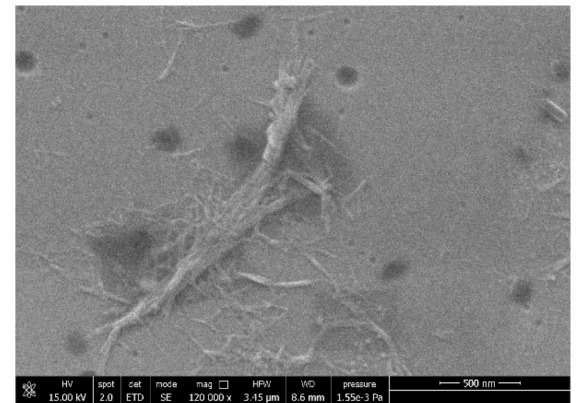
Figure 5. ESEM micrograph obtained for